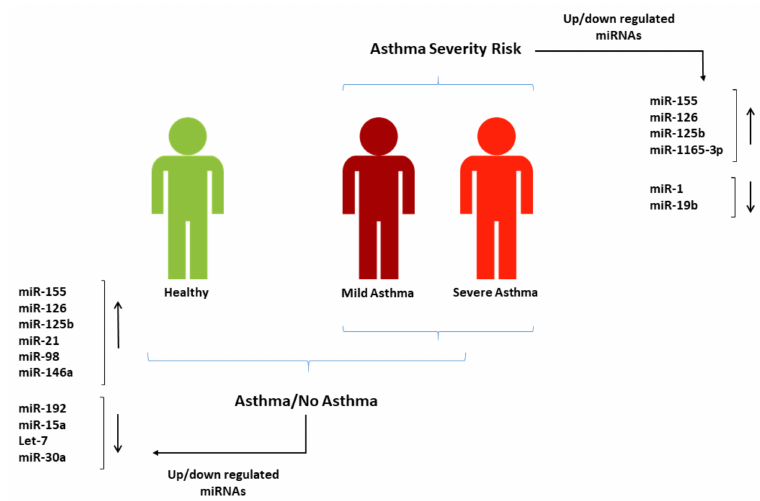
Figure 5. Suggested miRNA panels from the studies included in this systematic review that can be used in blood for asthma diagnosis and severity-risk